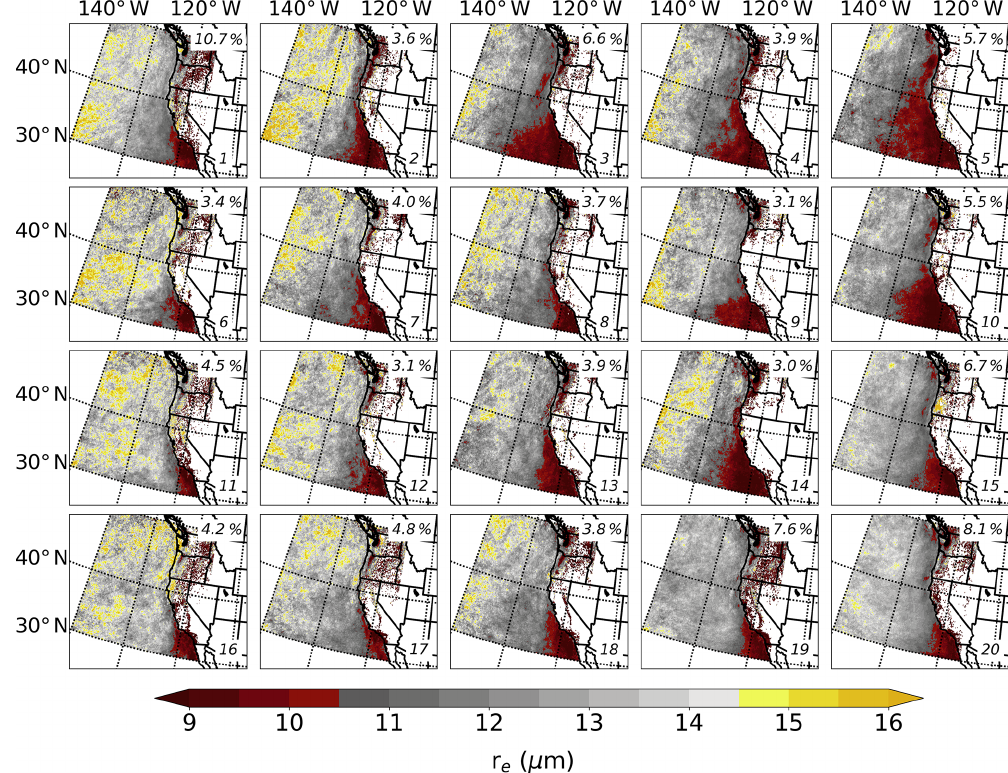
Figure 6. As in Fig. 5 except for the MODIS retrieval of r e (contoured every 0.5µm according to the color